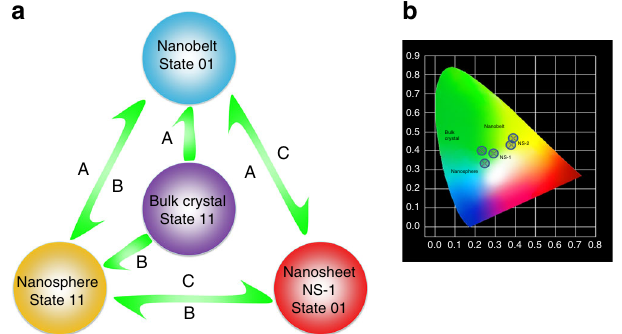
Fig. 4 Morphological transformation. a Transformation relationship and optical memory states for nanobelts, nanospheres, and nanosheets (NS-1). Transformation conditions under ultrasound: A, in H 2 O; B, in DMF/ H 2 O (v/v = 1/2, water content: 67%); C, in DMF/H 2 O (v/v = 5/2). State 01 refers to interlayer emission off + intralayer emission on, and State 11 refers to interlayer emission on + intralayer emission on. b Emitting color tone shown by CIE coordinates